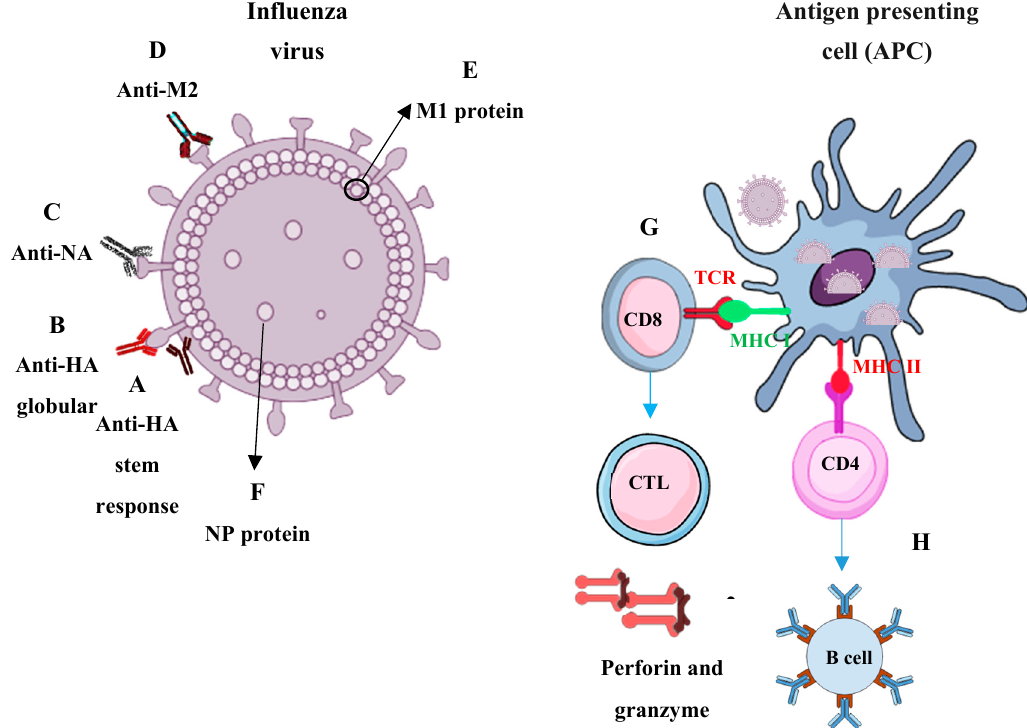
Figure 1. Antigens for universal influenza vaccine development. ( A ) Neutralizing antibodies against highly conserved hemagglutinin (HA) (major protein of influenza virus) stem can provide broadly protective immune responses and cross-protection. ( B ) Neutralizing antibodies against the globular head of HA can prevent virus binding to sialic acid and prevent the conformational change that leads to fusion. ( C ) Anti- neuraminidase (NA) (second major protein of influenza virus) response targets the enzymatic site to prevent virus entry, inhibit replication efficiency, decrease disease severity after infection and cross-protection. ( D ) Anti- matrix protein 2 (M2) antibodies (third major protein of influenza virus) provide a better cross-protective response due to the high conservation. Non- neutralizing Ab against this domain mediates its mediates protection by antibody -dependent cell- mediated cytotoxicity. ( E ) matrix protein 1 (M1) is an internal protein which is generally not exposed outside of the virus and needs to be processed by major histocompatibility complex I (MHC I) for CD8 T cell antigen recognition. ( F ) Highly conserved nucleoproteins (NP) viral proteins being used as a target to CD8 T cells to provide better protection from several infections. ( G ) CD8 T cells recognize peptides derived from variable (HA and NA) and highly conserved internal proteins (NP and M1) presented by MHC I at the surface of antigen presenting cell (APC)/infected cells via their T cell receptor (TCR). Cytotoxic T lymphocytes (CTL) release cytotoxic granules containing perforin and granzymes which lysis the infected cells. ( H ) Memory CD4 T cells are required for early Ab and CD8 T cell recruitment responses.